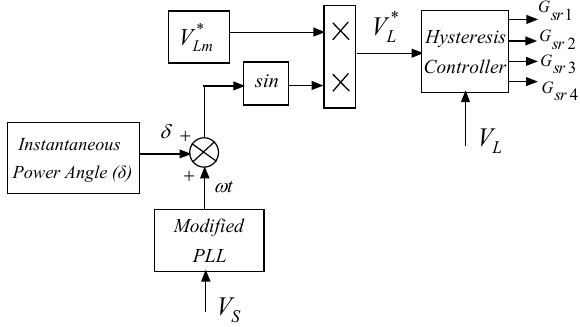
Figure 3. PAC-SRF-based series Figure 3. PAC ‐ SRF ‐ based series APF.